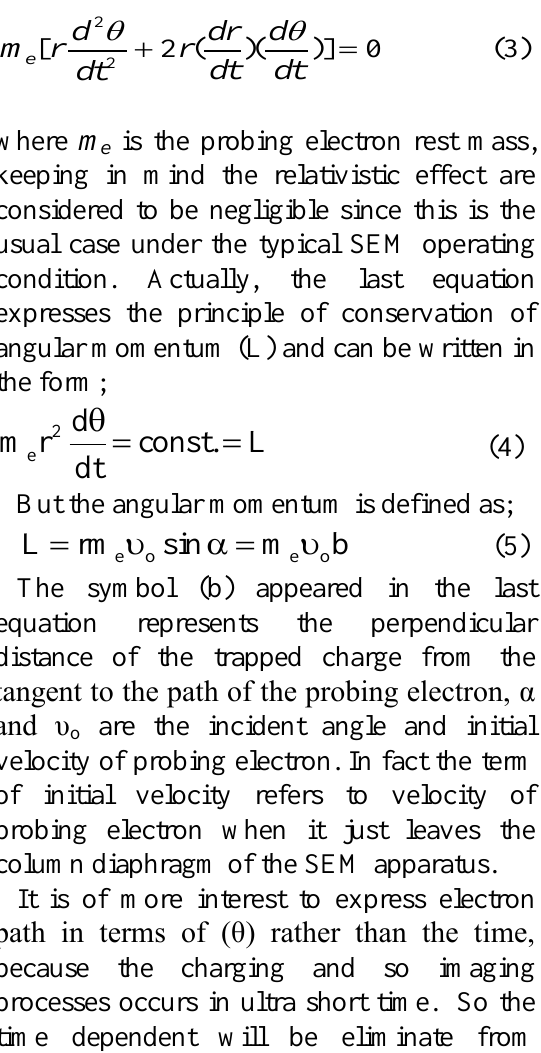
Fig.2: Geometrical illustration for the derivation of the electron path